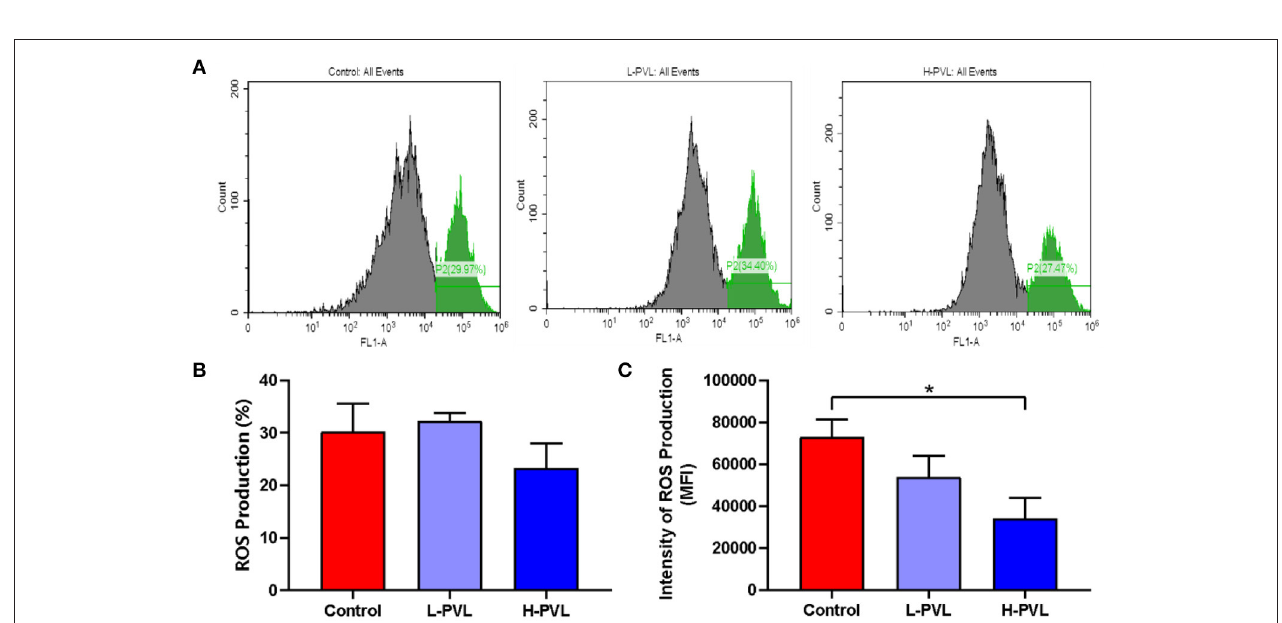
FIGURE 5 | Effect of BLV infection on respiratory burst of PMN. (A) Effect of BLV infection on respiratory burst of PMN, (B) Effect of BLV infection on ROS production efficiency of PMN, and (C) Effect of BLV infection on ROS production in PMN. * P < 0.05 compared to healthy cows.